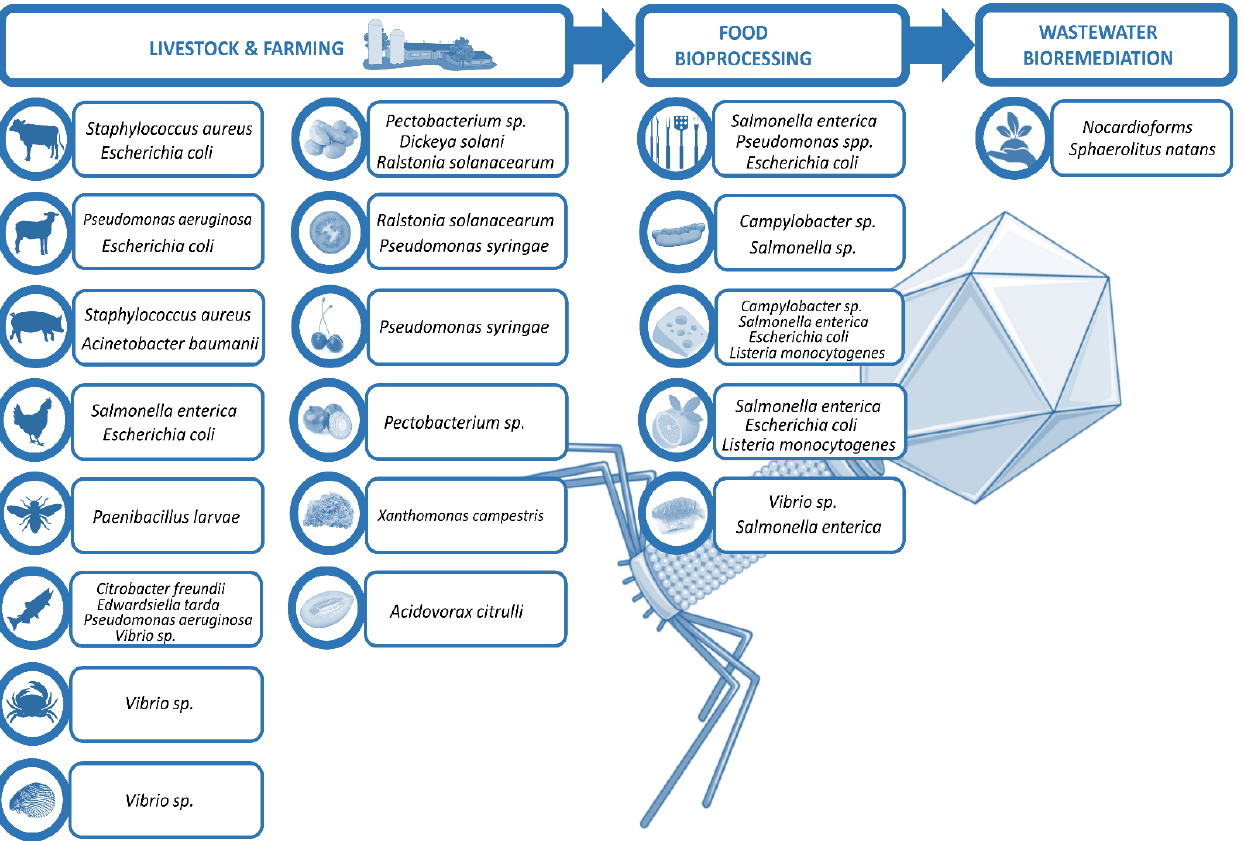
Figure 1. Scheme of phage utilities in biocontrol.